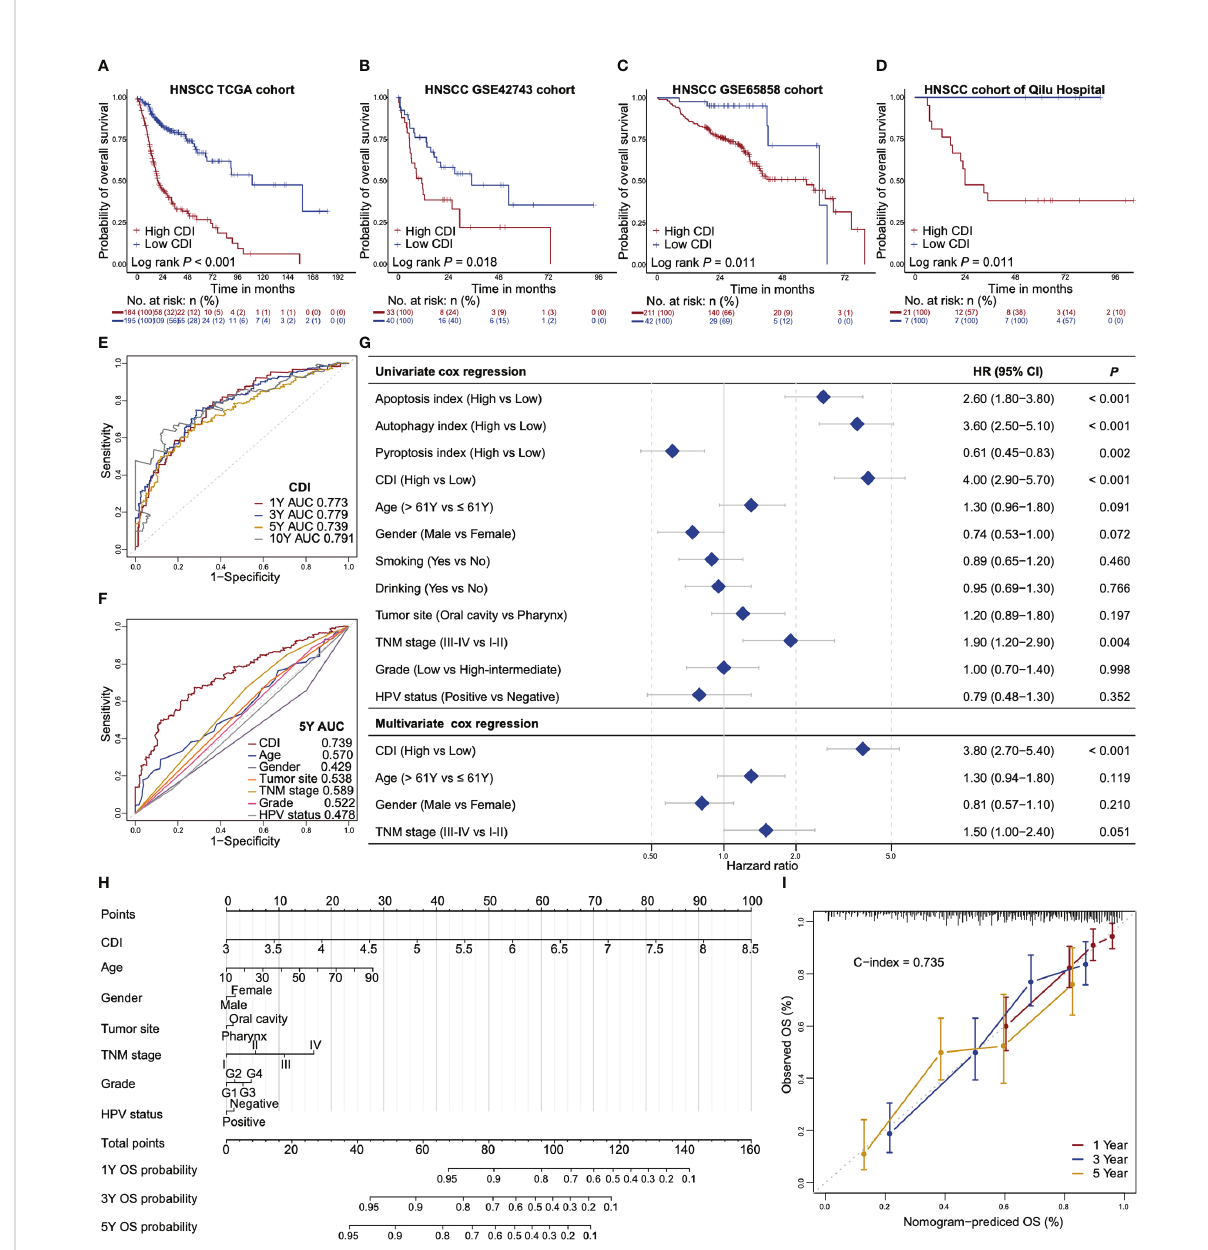
FIGURE 2 CDI is an independent prognostic indicator for overall survival of HNSCC. (A – D) Kaplan-Meier survival curves of high CDI and low CDI subgroups in TCGA dataset (A) , GSE42743 dataset (B) , GSE65858 dataset (C) and the dataset of Qilu Hospital of Shandong University (D) . Log- rank test is used to assess the statistical signi fi cance. (E) ROC curves of CDI for the prediction of overall survival at one-year, three-year, fi ve- year and ten-year. (F) ROC curves of CDI and clinicopathological factors for prediction of fi ve-year overall survival. (G) Forest plots of the univariate and multivariate Cox regressions of CDI, indices of apoptosis, autophagy and pyroptosis and the clinicopathologic characteristics for overall survival. (H) A nomogram estimates the probabilities of one-year, three-year, fi ve-year overall survival for HNSCC patients based on CDI and clinicopathologic characteristics. (I) Calibration plots of the nomogram in terms of agreement between the predicted and observed one- year, three-year and fi ve-year overall survival. The close-ended vertical lines indicate the 95% CI, the dashed line represents the ideal performance of the nomogram. HNSCC: head and neck squamous cell carcinoma; CDI: cell death index; ROC: receiver operator characteristic curve; AUC: areas under the curve; TNM: tumor-node-metastasis; HPV: human papillomavirus; HR: hazard ratios; CI: con fi dential interval; C- index: Harrell ’ s concordance index using “ Hmisc ”